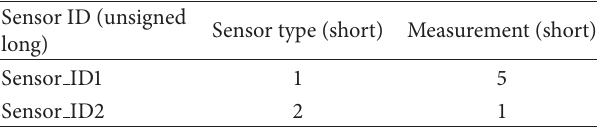
Table 1: Output table of the Alarm Monitoring Service.